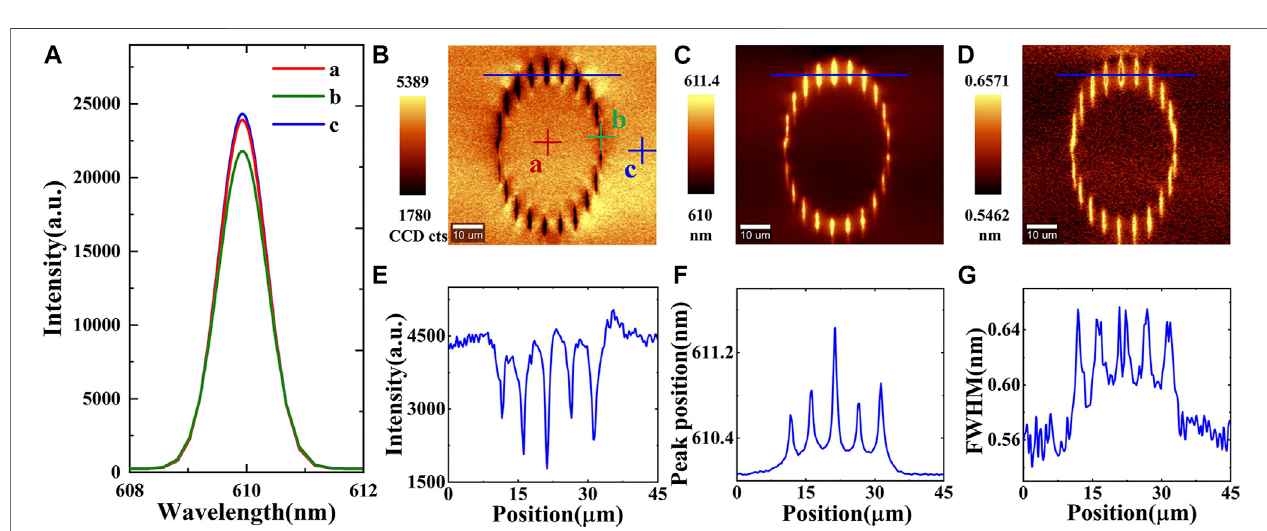
FIGURE 3 | (A) The μ -PL spectroscopy of WG16 obtained from the inner core (a), processing track (b) and bulk material (c). The 2D mappings and 1D pro fi les of intensity (B,E) , peak position (C,F) and FWHM (D,G) of μ -PL spectra obtained from the WG16. 1D pro fi les are measured along the blue lines in (B – D) .